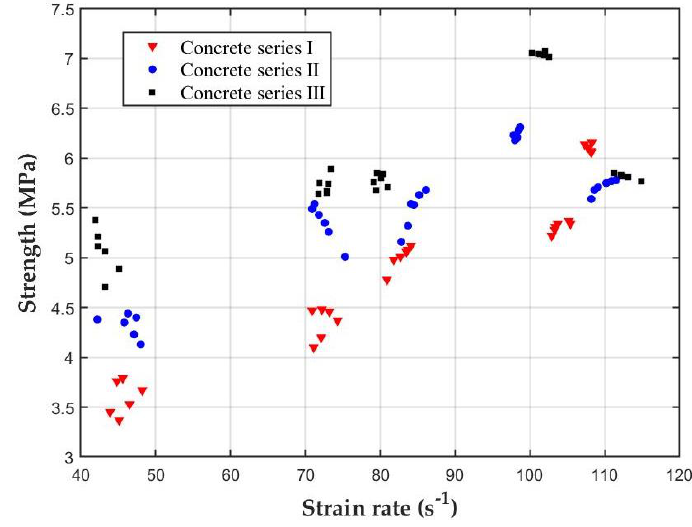
Figure 8. Relationship between the dynamic tensile strength and the strain rate of concrete with different SF rate levels.